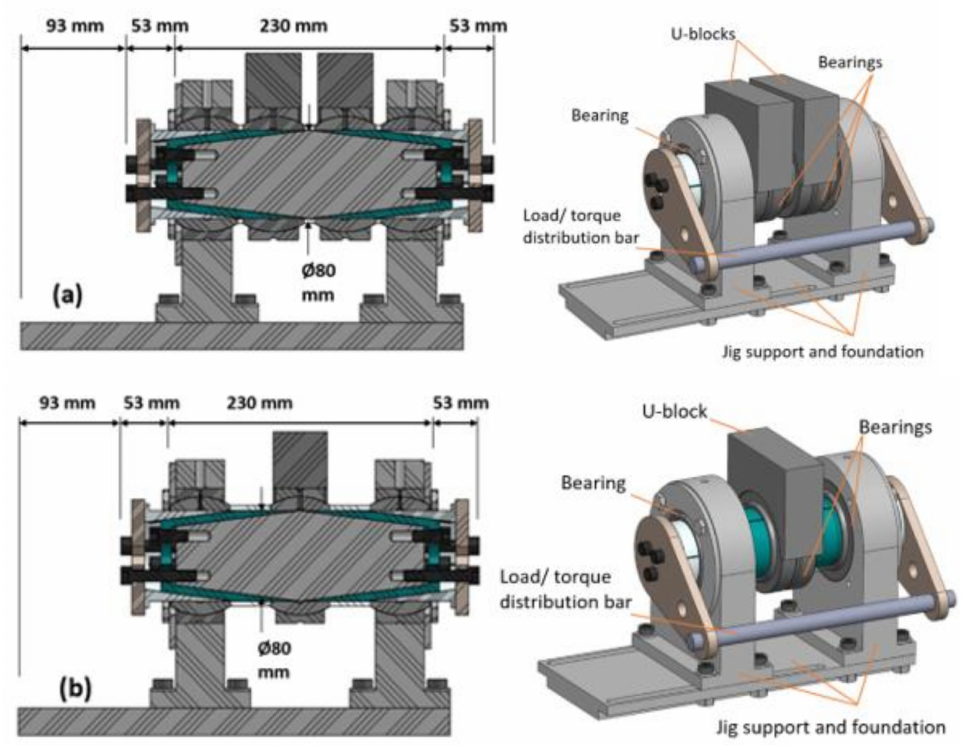
Figure 5. Test setup for Test 2: ( a ) Test 2a—cross sectional view (left) and view with isometric part names (right); ( b ) Test 2b—cross sectional view (left) and isometric view with part names